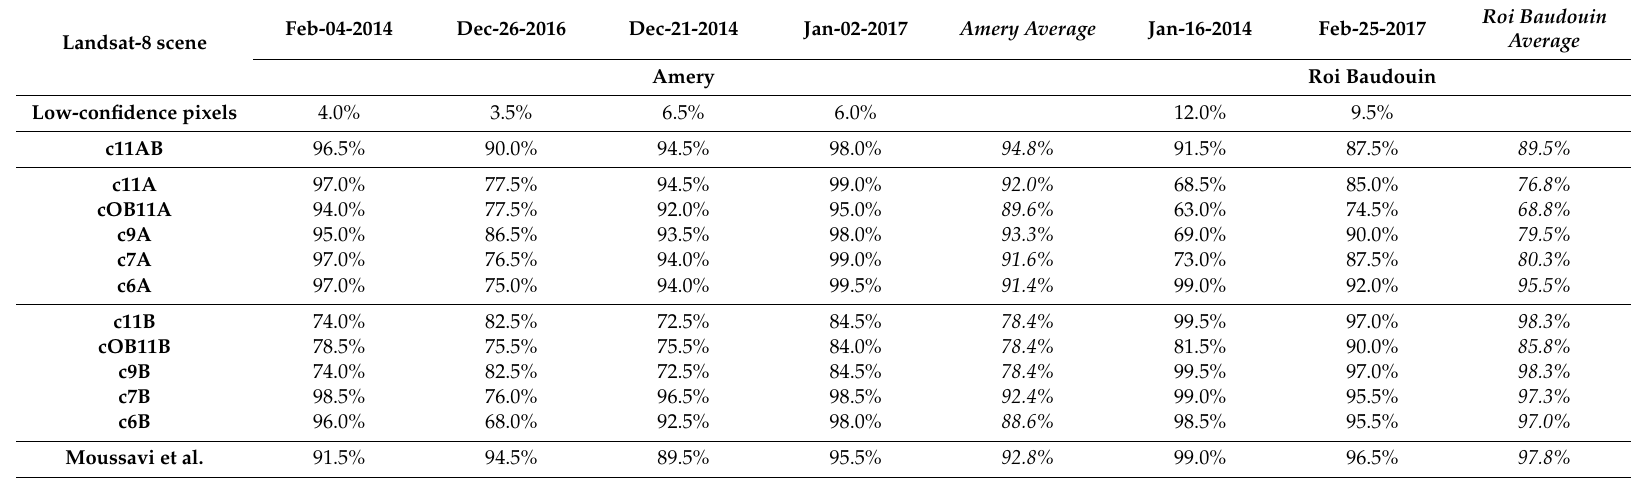
Table 3. We use a visually interpreted dataset of individual pixels to validate trained classifiers (Table 1), as well as the multi-band thresholding method from Moussavi et al. [85]. We also report the percentage of low-confidence pixels within our validation dataset, reflecting the potential inaccuracies associated with visual interpretation (Section 2.4.). Percentages are classifier lake / non-lake overall accuracy applied to the lake / non-lake pixels. Validation scenes are identified by